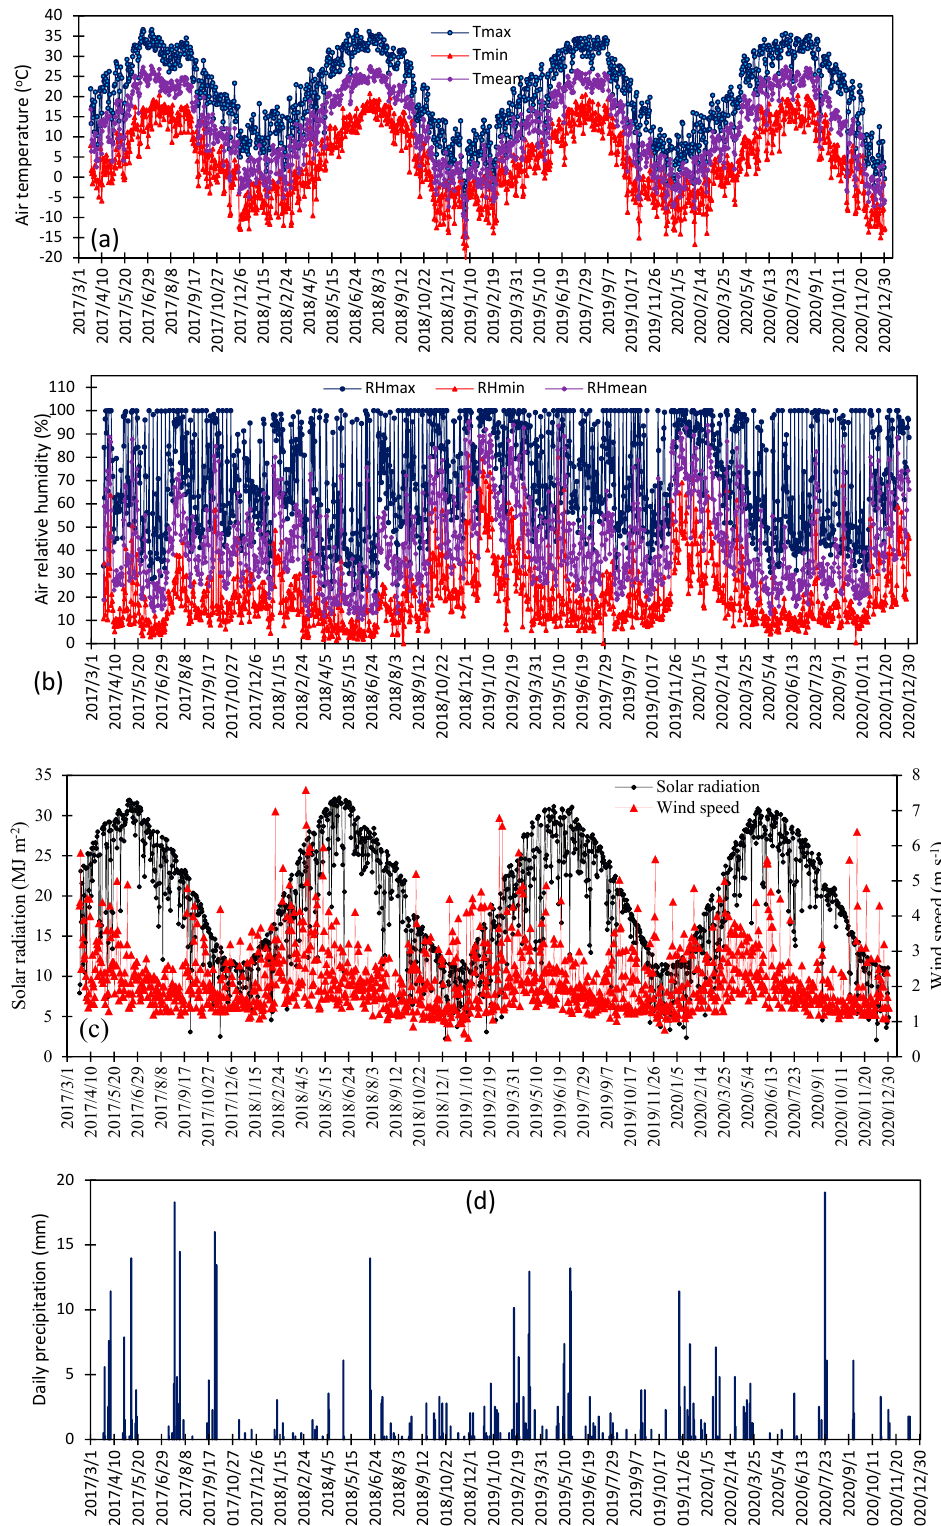
Figure 3. Weather conditions during the 2017–2020 period at the experiment station: ( a ) air temperatures, ( b ) air relative humidity, ( c ) wing speed and solar radiation, and ( d ) precipitation.